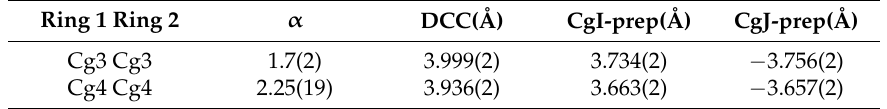
Table 4. π – π stacking interactions (Å, ° ) for complex 1 .